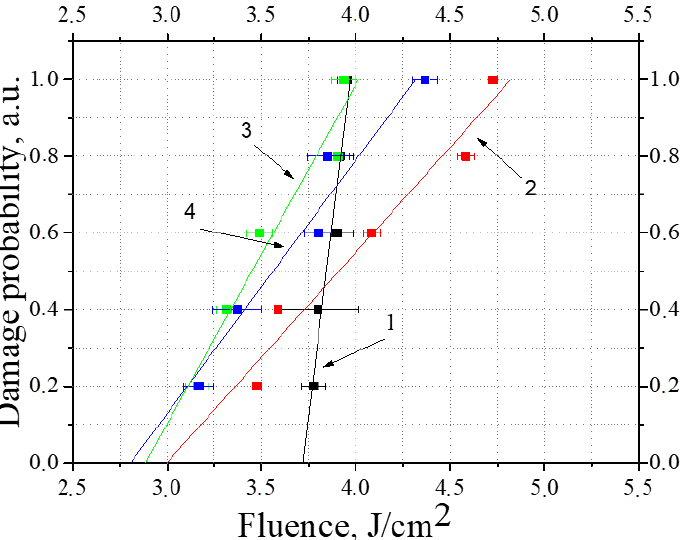
Figure 5. Damage probability of the ZnSe_Ar sample vs the laser beam fluence for different exposure durations of the Ho 3+ :YAG laser (at 16 kHz PRR): 1 s (1), 20 s (2), 40 s (3), 60 s (4).